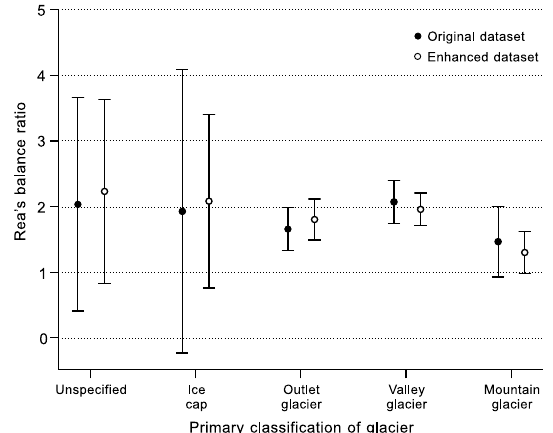
Figure 10. Balance ratio (Rea, 2009) vs. primary classification of glacier. Version 1 is for the original data (66 glaciers) and version 2 is for an augmented data set (103 glaciers) using a regression line in Fig. 9. Error bars represent 95% confidence intervals of the means according to Student’s t